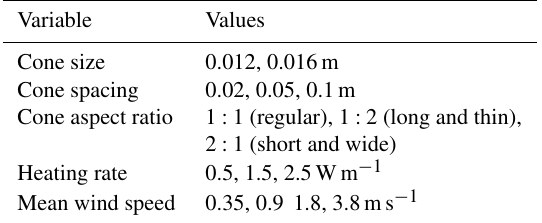
Table 1. Tested parameters values.